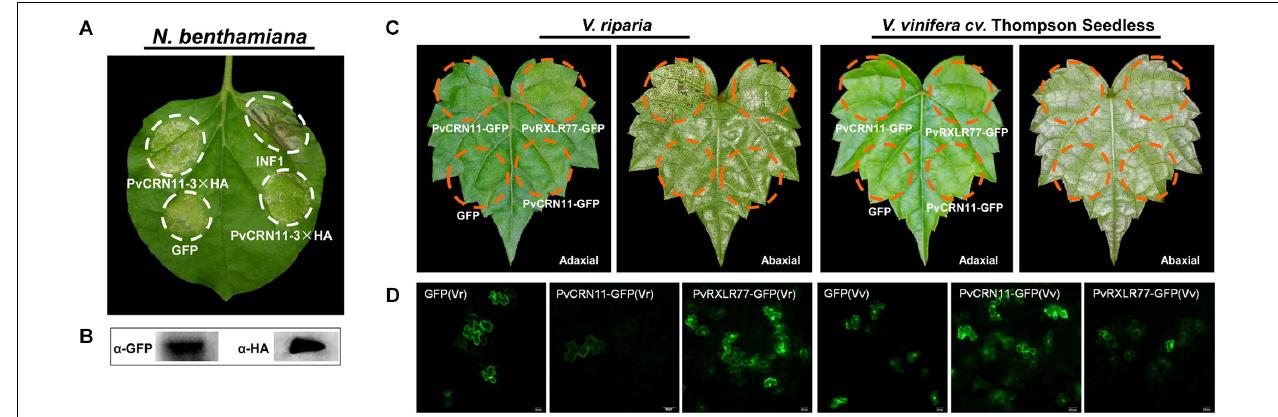
FIGURE 5 | PvCRN11 induced cell death in N. benthamiana leaves but failed to induce cell death in V. riparia and V. vinifera cv. Thompson seedless leaves. (A) PvCRN11 induced spotted necrosis on N. benthamiana leaves. Constructs PVX- GFP and PVX- INF1 were transiently expressed along with PVX1- PvCRN11 in N. benthamiana leaves as the negative and positive controls for plant cell death induction, respectively. The expression of each construct was verified by western blot, except for INF1 since the plant cell death phenomena induced by PVX- INF1 were typical, even though there was no accessible corresponding antibody (B) . Photographs were taken 5–8 days after agroinfiltration. (C) PvCRN11 did not induce HR-like cell death on V. riparia (left) or V. vinifera cv. Thompson seedless (right) leaves. PvRXLR77-GFP and GFP were expressed in grapevine leaves simultaneously with PvCRN11-GFP, and their corresponding resulting phenomena served as the positive and negative controls, respectively. The expression of each recombinant protein was confirmed through observing GFP fluorescence in the infiltrated leaves 72–120 h post agroinfiltration (D) . Photographs of grapevine leaves were taken 7–10 days after agroinfiltration. The experiment was repeated at least three times with at least six leaves tested in each independent